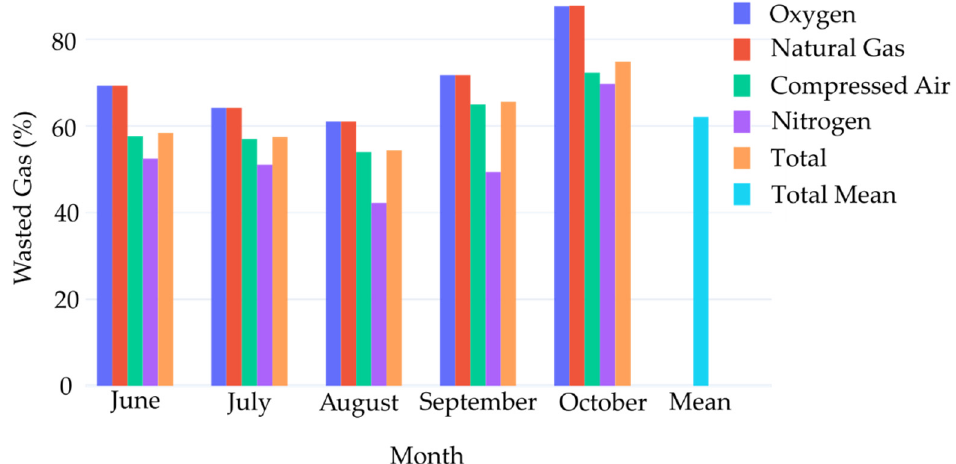
Figure 11. Percentage of waste by gas type.